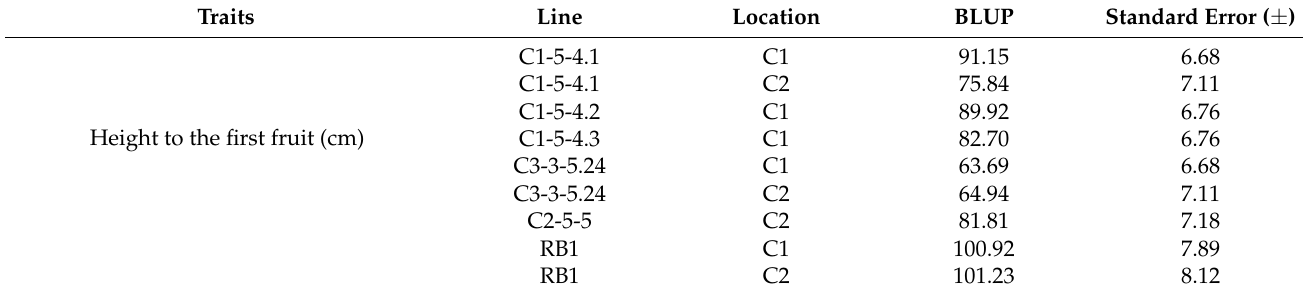
Table 5. F5 RIL ranked for the breeding value or genetic worth (BLUPs) of each trait in the Coastal environment (C1 and C2) compared to commercial